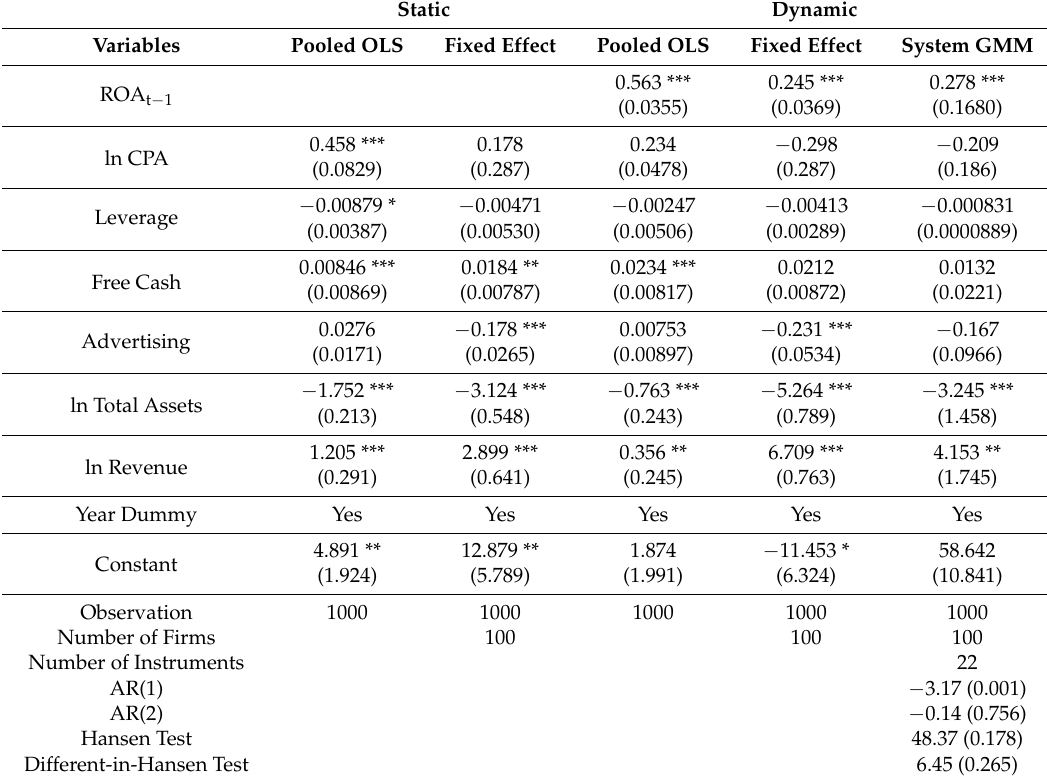
Table 3. The Impact of CPA on Firm Performance